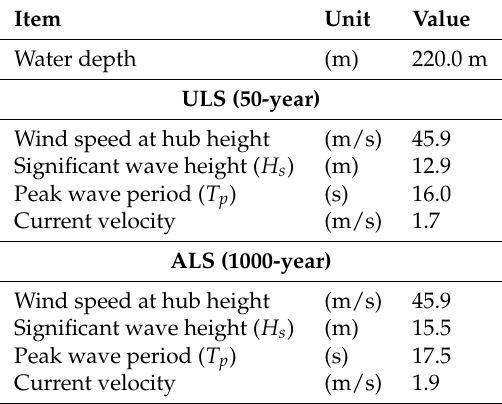
Table 1. Extreme metocean conditions for ultimate limit state (ULS) calculations.